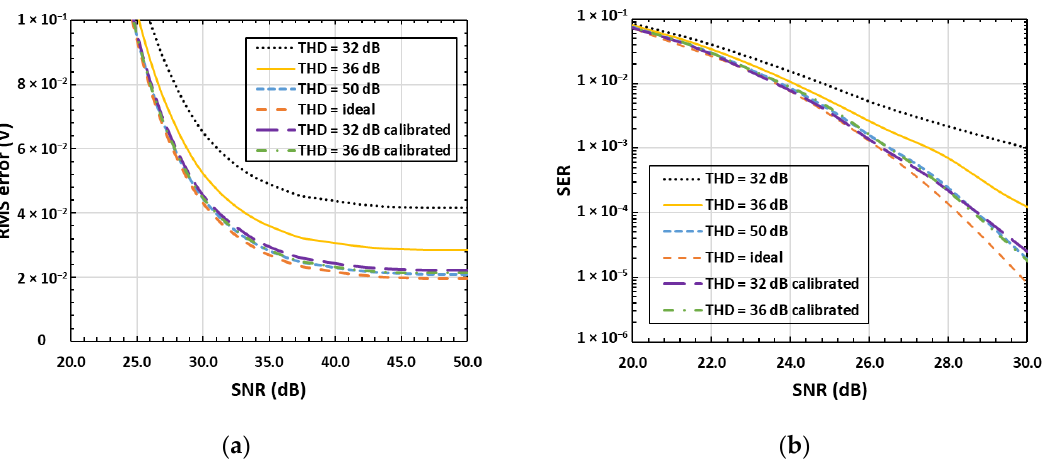
Figure 11. ( a ) MSE (in volts from the ideal reconstruction of the digital values) and ( b ) SER as a function of SNR for different levels of AFE static THD and for two AFE THD values after calibration derived using a MATLAB simulation of a PAM-8 receiver.